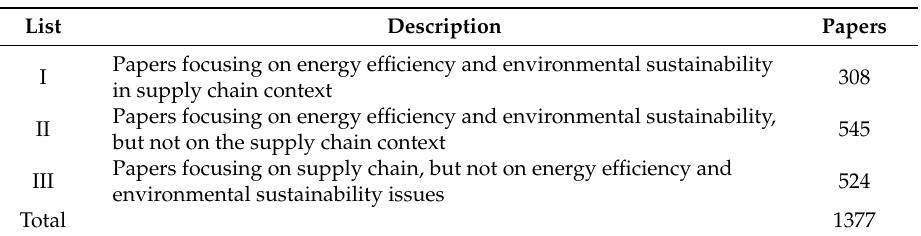
Table 3. Three selection